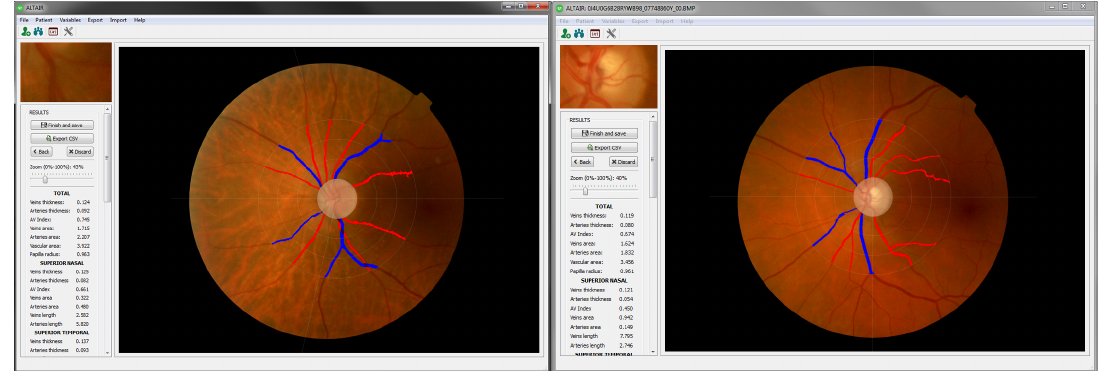
Figure 8. Software screenshots on the last step of the analysis of two different